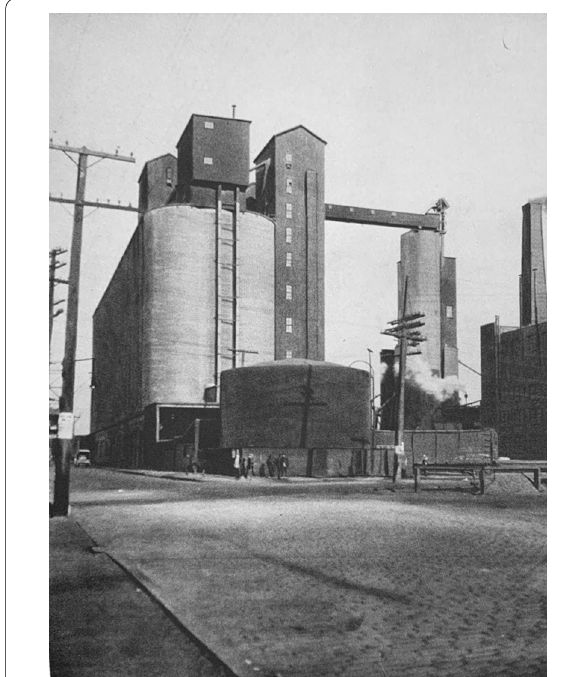
Fig. 5 Grain silos. Buffalo, New York. Erich Mendelsohn. 1926. From his book Amerika. Bilderbuch eines Architekten (Berlin: Rudolf Mosse/ Buchverlag, 1926)